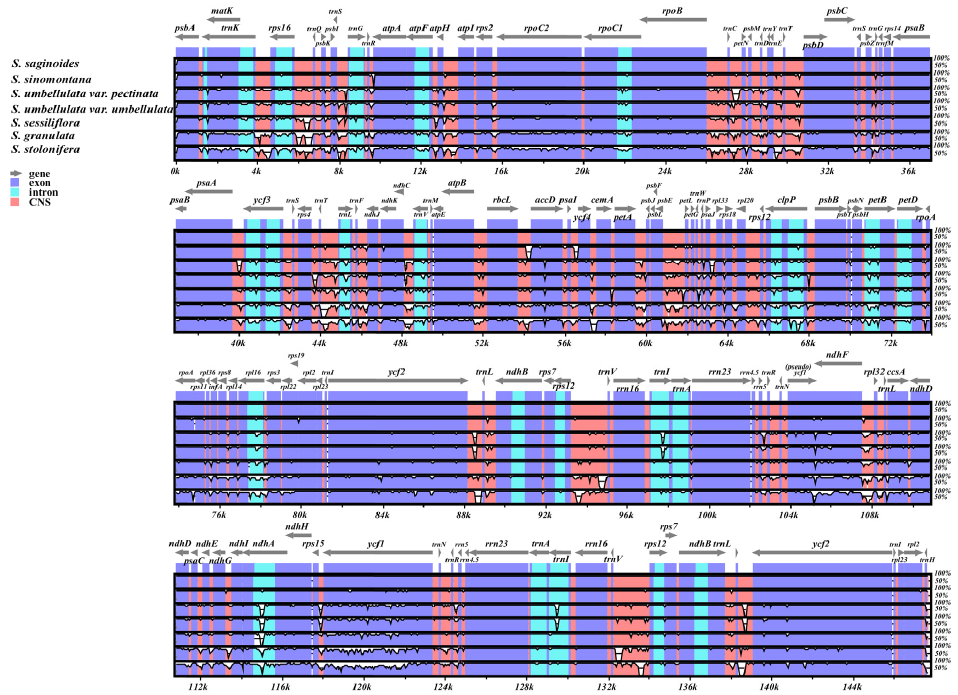
Figure 3. The alignment and comparative analysis of the whole cp genome for seven Saxifraga species. Among them, S. saginoides was set as reference. The horizontal axis represents the coordinates of cp genomes in the alignment result. Exons, introns, and conserved noncoding sequences (CNSs) were marked as different